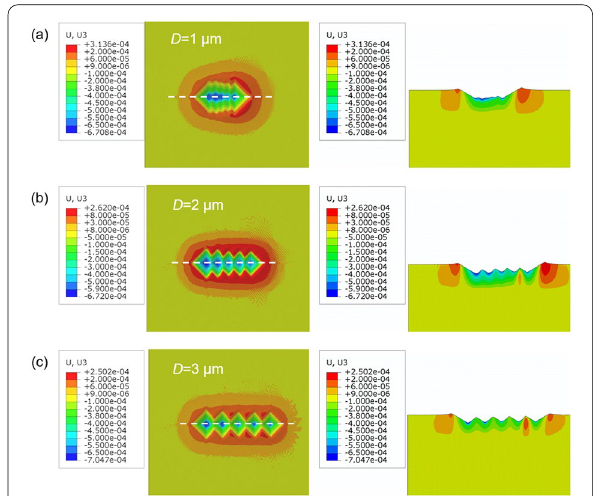
Figure 8 Top views and the corresponding cross-sections of the simulated results for the one array indentations with the rotation angle of 0° and the spacing of a 1 μm, b 2 μm and c 3 μm